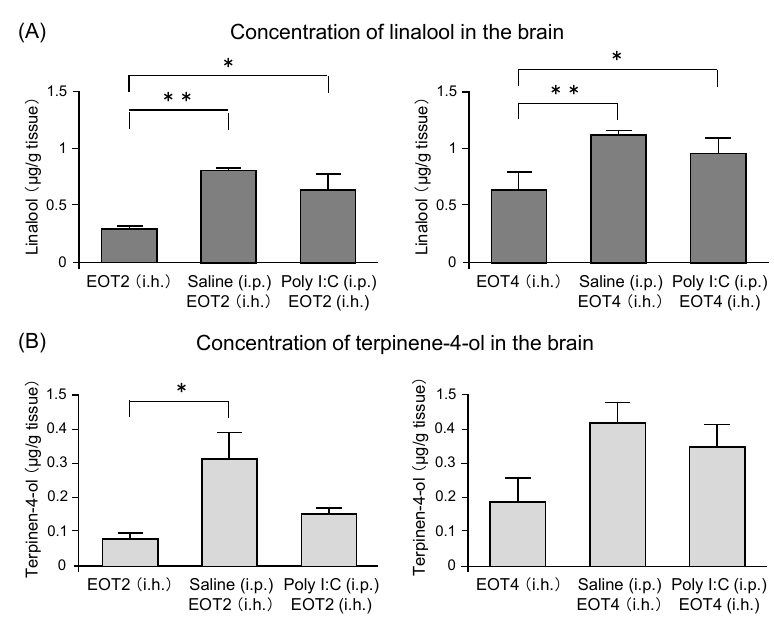
Figure 11. The concentrations of linalool and terpinen-4-ol in the mouse brain after i.h. of thyme. Three groups of mice loaded with weak stress by breeding alone: thyme (EOT) (i.h.) group, EOT (i.h.) after moderate stress by i.p. injection of saline or Poly I:C. ( A ): Linalool concentration after EOT (2 or 4 mL/L air, i.h.), ( B ): Terpinen-4-ol concentration after EOT (2 or 4 mL/L air, i.h.). The results show means ± SEM (n = 4). * p < 0.05, ** p < 0.01 (Tukey–Kramer test). This figure is modified based on the original figure [122] with the copyright permission.